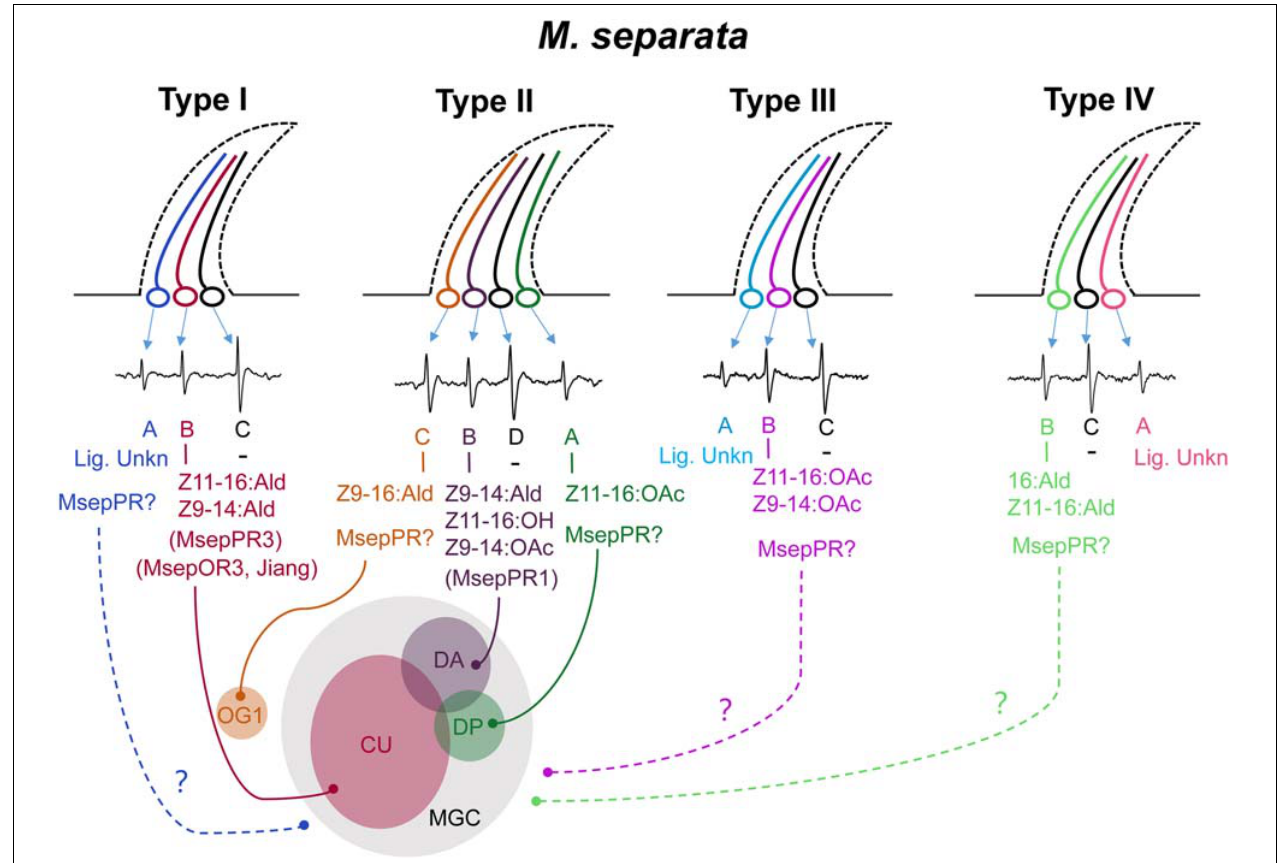
FIGURE 6 | A schematic diagram of olfactory coding of sex pheromones and analogs in male M. separata at the peripheral and central nervous system. Four functional types of TS were characterized. The classification of neurons housed in type-II TS is modified by our SSR recording and the reported results by Jiang et al. (2020). Neuron of type-II TS activated by Z11–16:OAc is divided as a active one. In total, six ORNs are separately activated by major and minor sex pheromone components and their analogs. “–” indicates the largest spontaneous action potential without ligands identified. “Lig. Unkn” indicates no ligand has been characterized for a specific neuron by SSR recording. The curves with solid lines indicate candidate project pathways. The curves with dotted lines indicate unknown project pathways. MGC, macroglomerular complex; CU, cumulus; DA, dorso-anterior; DP, dorso-posterior; and OG1, ordinary glomerulus